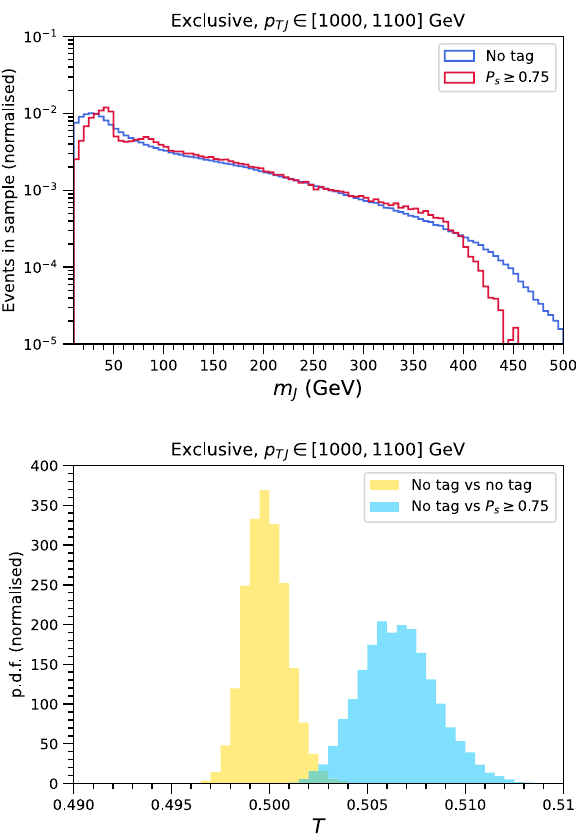
Fig. 17 Top: Jet mass distribution for QCD jets with p T ∈ [ 1000 , 1100 ] GeV, without cuts and after a fixed cut P GenT 3 tagger. Bottom: Probability density functions for the estimator T , obtained when the two samples are drawn from the untagged jet pool (yellow) or from the untagged pool of jets tagged with fixed threshold P s ≥ 0 . 75